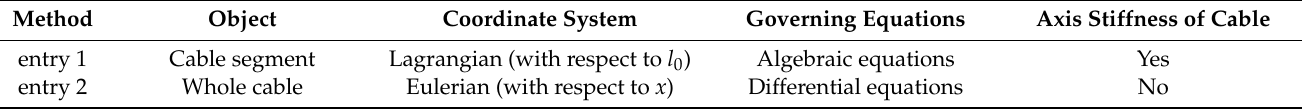
Figure 3. Flowchart of the iteration scheme for solving the cable shape of segmental catenary method. A comparison between the SCM and present NFEM is shown in Table 1. The SCM focuses on each cable segment to develop its analytical expression of the cable shape using algebraic equations (Equations (34) and (36)) in the Lagrangian coordinate system with respect the unstrained cable length l 0 . The present NFEM solves the differential equations of the whole cable in the Eulerian coordinate system with respect the bridge axis coordinate x using the nonlinear finite element approximation. The SCM requires the inputs of the axis stiffness of the cable, i.e., E c A c to determine the unstrained cable length while no information regarding the cable material or cross section is needed in the NFEM for solving the cable shape. It is noteworthy that the unstrained cable length, which is of subtracting the elongation from the final length of the cable. Table 1. Comparison between the SCM and